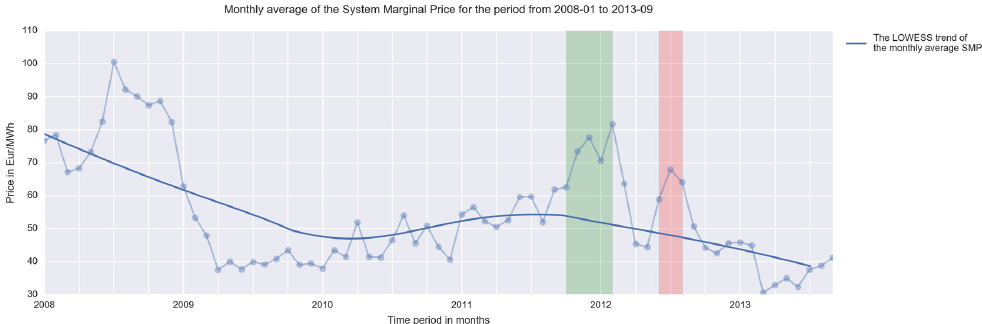
Figure 4. Evolution of the monthly average SMP in the Greek power market from 1 January 2008 to 30 September 2013—SMP ( y ‐ axis) is in Euro/MWh, and time ( x ‐ axis) is in years.